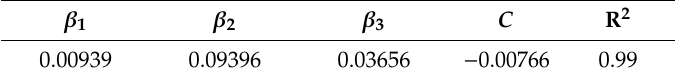
Table 4. Discharge—Flow-depth multi linear regressing coefficients.